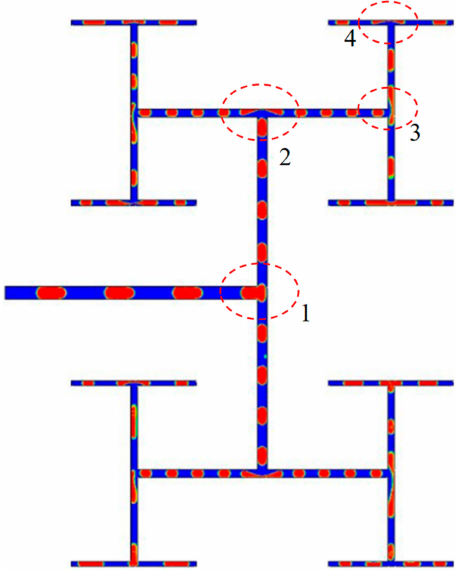
Figure 1. Typical case of bubble breaking up in fractal tree-shaped microchannel (Ca 0 =